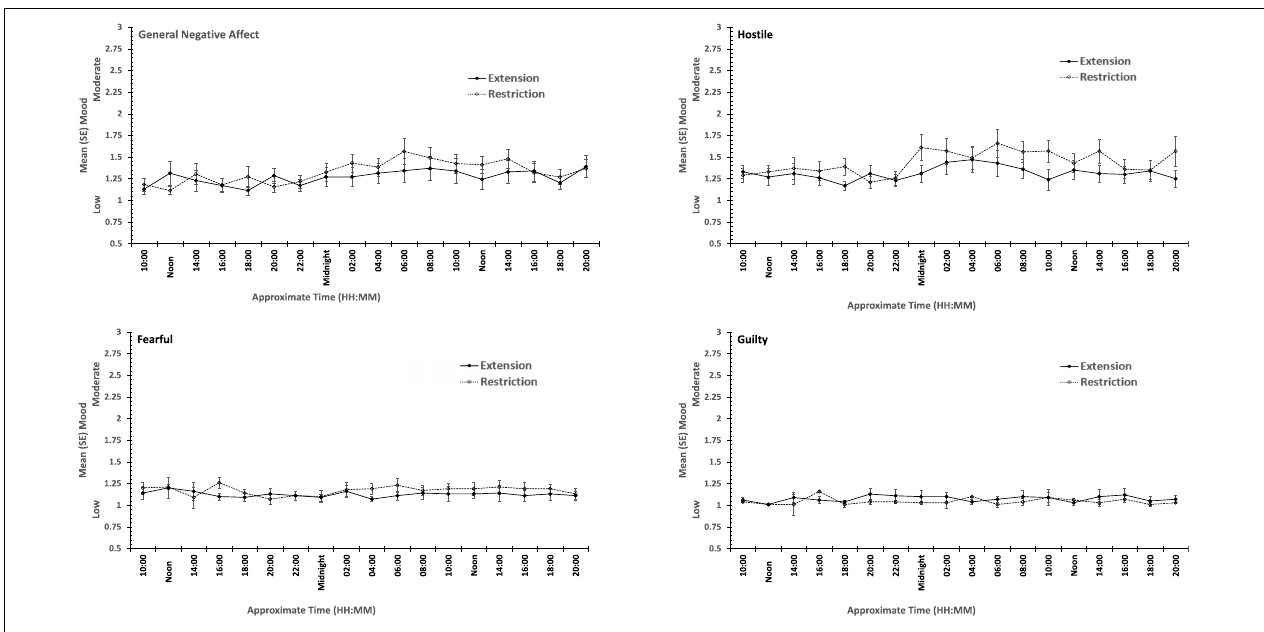
FIGURE 5 | Effects of prior sleep restriction and extension on Negative Mood (General Negative Affect, Fearfulness, Guilt, Hostility) across 38 h of